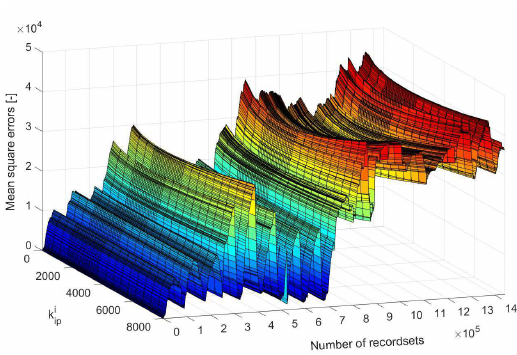
Figure 9. The resulting value of k i as a minimum of control